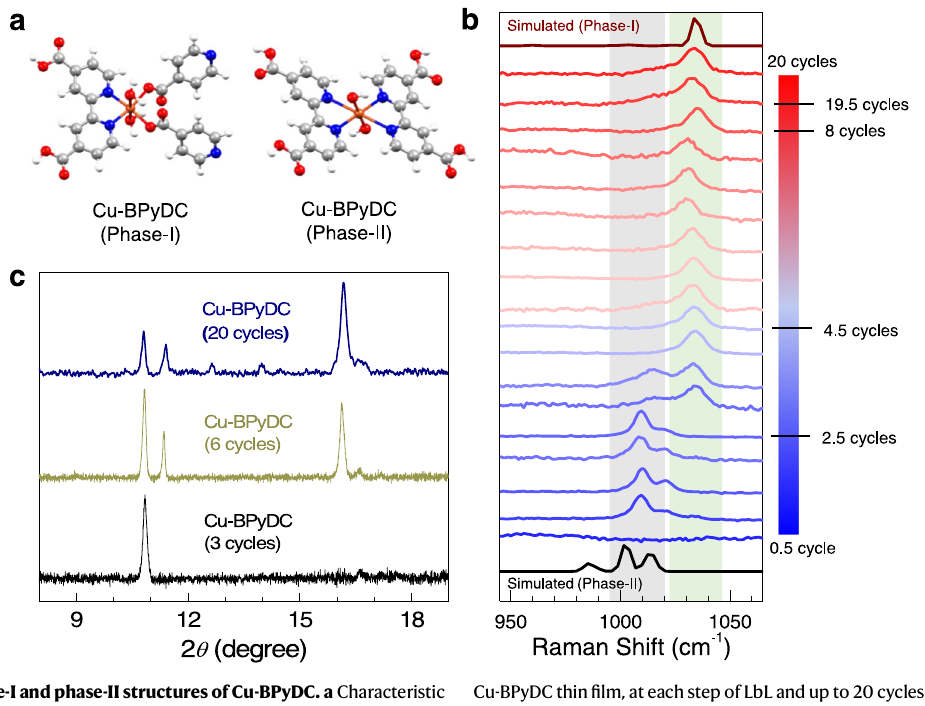
Cu-BPyDCthin fi lm,ateachstepofLbLandupto20cycles;andcomparedwiththe theoretically simulated Raman spectra for phase-I and phase-II structures of Cu- BPyDC. c Out-of-planeXRDpatternsrecordedduringthegrowth(3cycles,6cycles, and 20 cycles) of pristine Cu-BPyDC thin fi